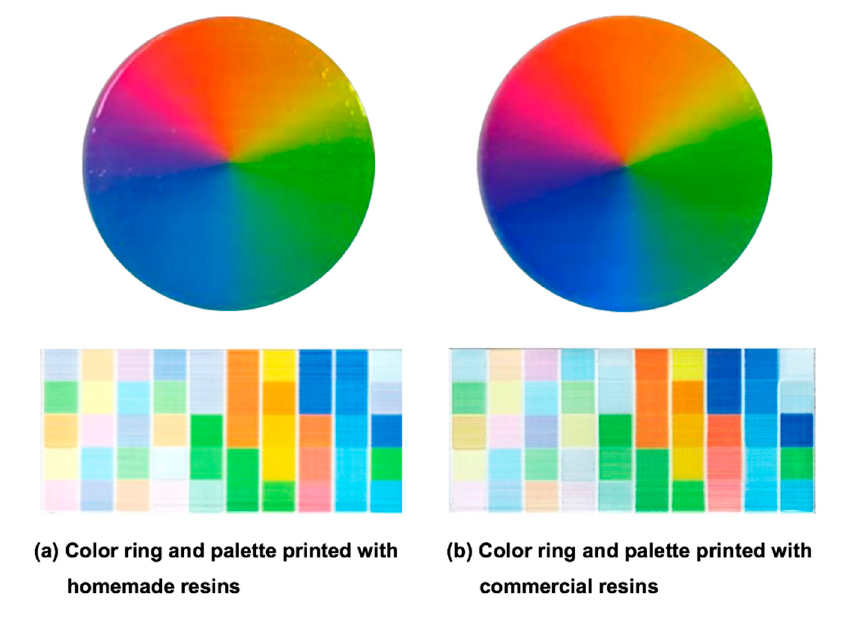
Figure 8. Color ring and palette printed with ( a ) homemade resins and ( b ) commercial resins.